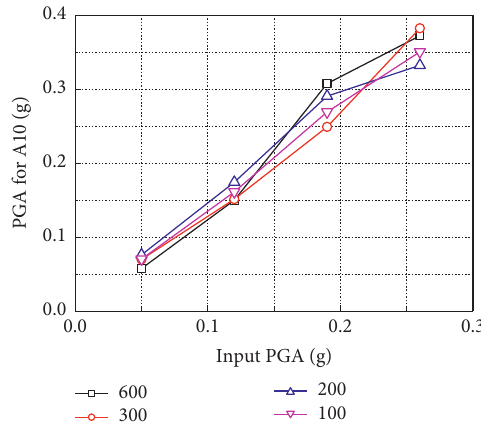
Figure 10: Pga of A10.